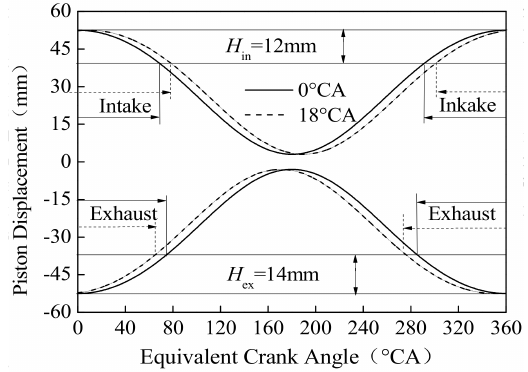
Figure 11. Effect of Phase Difference on Scavenging